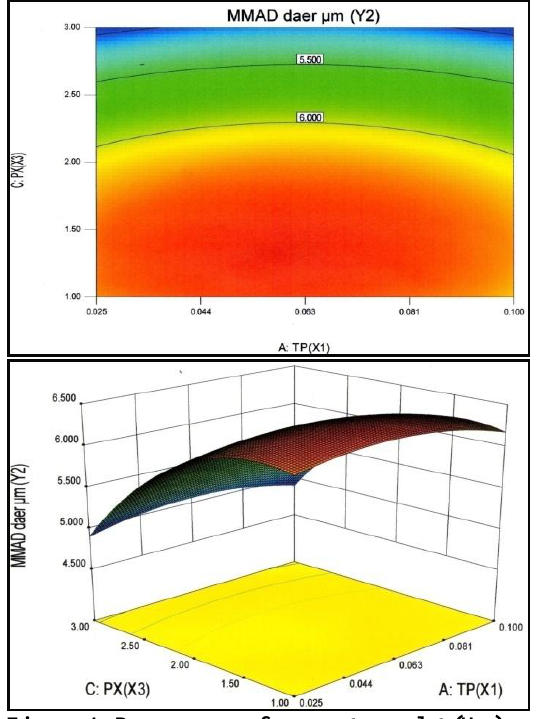
Figure 4: Response surface contour plot (Up) and 3D plot (down) for TP and PX effect on MMAD